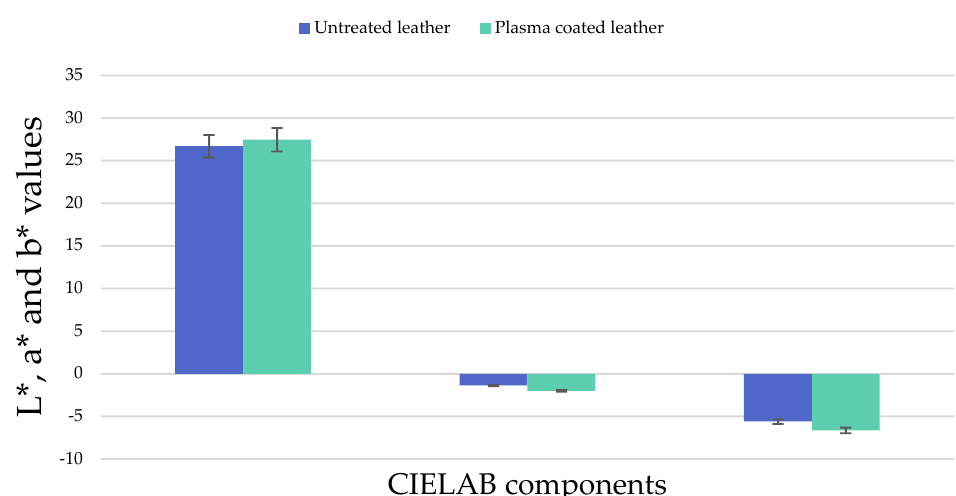
(b) Figure 5. SEM images obtained before and after plasma polimerisation (440 x). (a) Untreated leather; (b) Plasma coated leather. 3.4. Colour Change Measurements